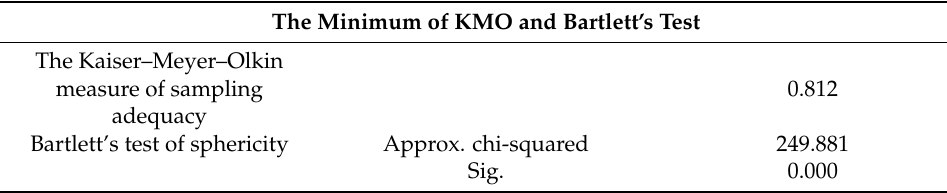
Table 3. Results of validity